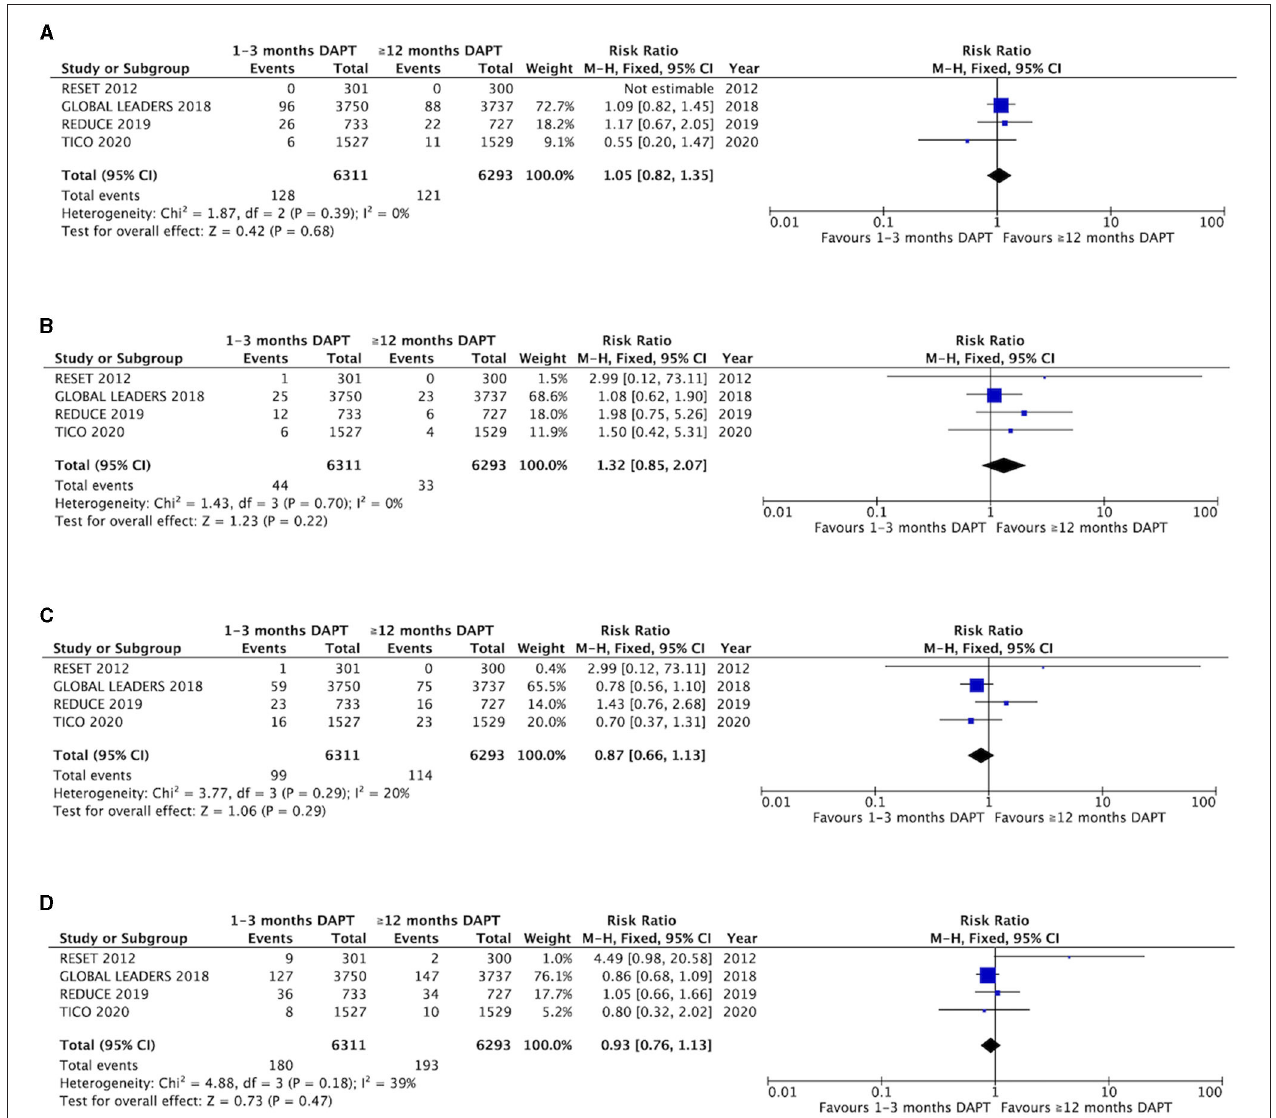
FIGURE 2 | Comparison of efficacy endpoints between groups with short-term and long-term DAPT. (A) myocardial infarction, (B) stent thrombosis, (C) all-cause death, (D) target vessel revascualization.